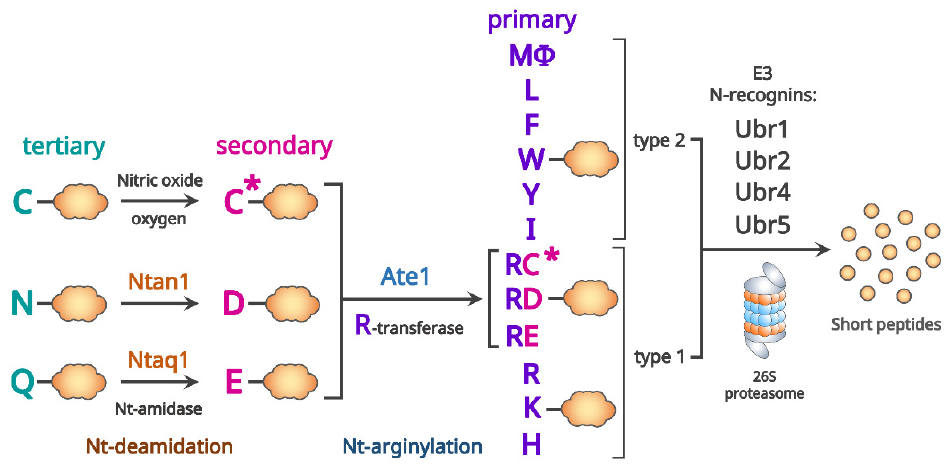
Figure 2. The mammalian Arg/N-degron pathway. In mammals, Ubr1, Ubr2, Ubr4, and Ubr5 E3 ligases are N-recognins of the Arg/N-degron pathway. Arg/N-recognins have at least two binding sites each for type 1 or type 2 primary destabilizing Nt-residues. The tertiary N-terminal (Nt-) destabilizing residues are N-terminally deamidated (Nt-deamidation) by Nt-amidase, Ntan1 for Nt-Asn residue, and Ntaq1 for Nt-Gln residue, respectively. The Nt-Cys residue is exceptional; when Nt-Cys residue is oxidized (denoted by C*), it becomes the secondary Nt-destabilizing residue (but not always). The secondary Nt-destabilizing residues are Nt-arginylated by Arg-tRNA-transferase Ate1. Amino acid residues are denoted by single-letter abbreviations, and the rest of a substrate protein is denoted by an orange cloud (adapted from [130,148]).